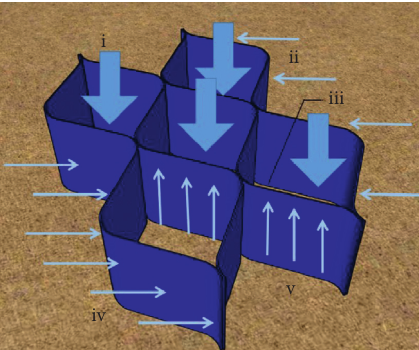
Figure 3: Configuration of a geocell. Reinforcement mechanism of a geocell. (i) Upper load, (ii) geocell wall, (iii) infilled soil, (iv) lateral restraint, and (v) anchorage or interfacial friction or both.